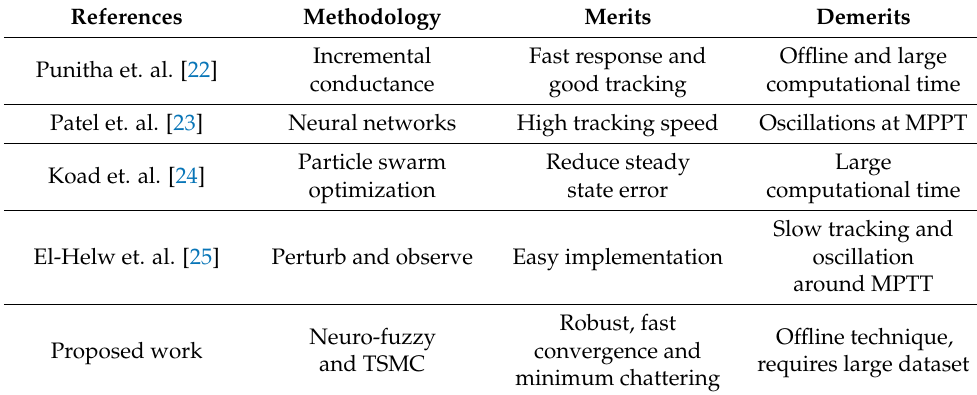
Table 1. Comparison of proposed work with existing techniques.